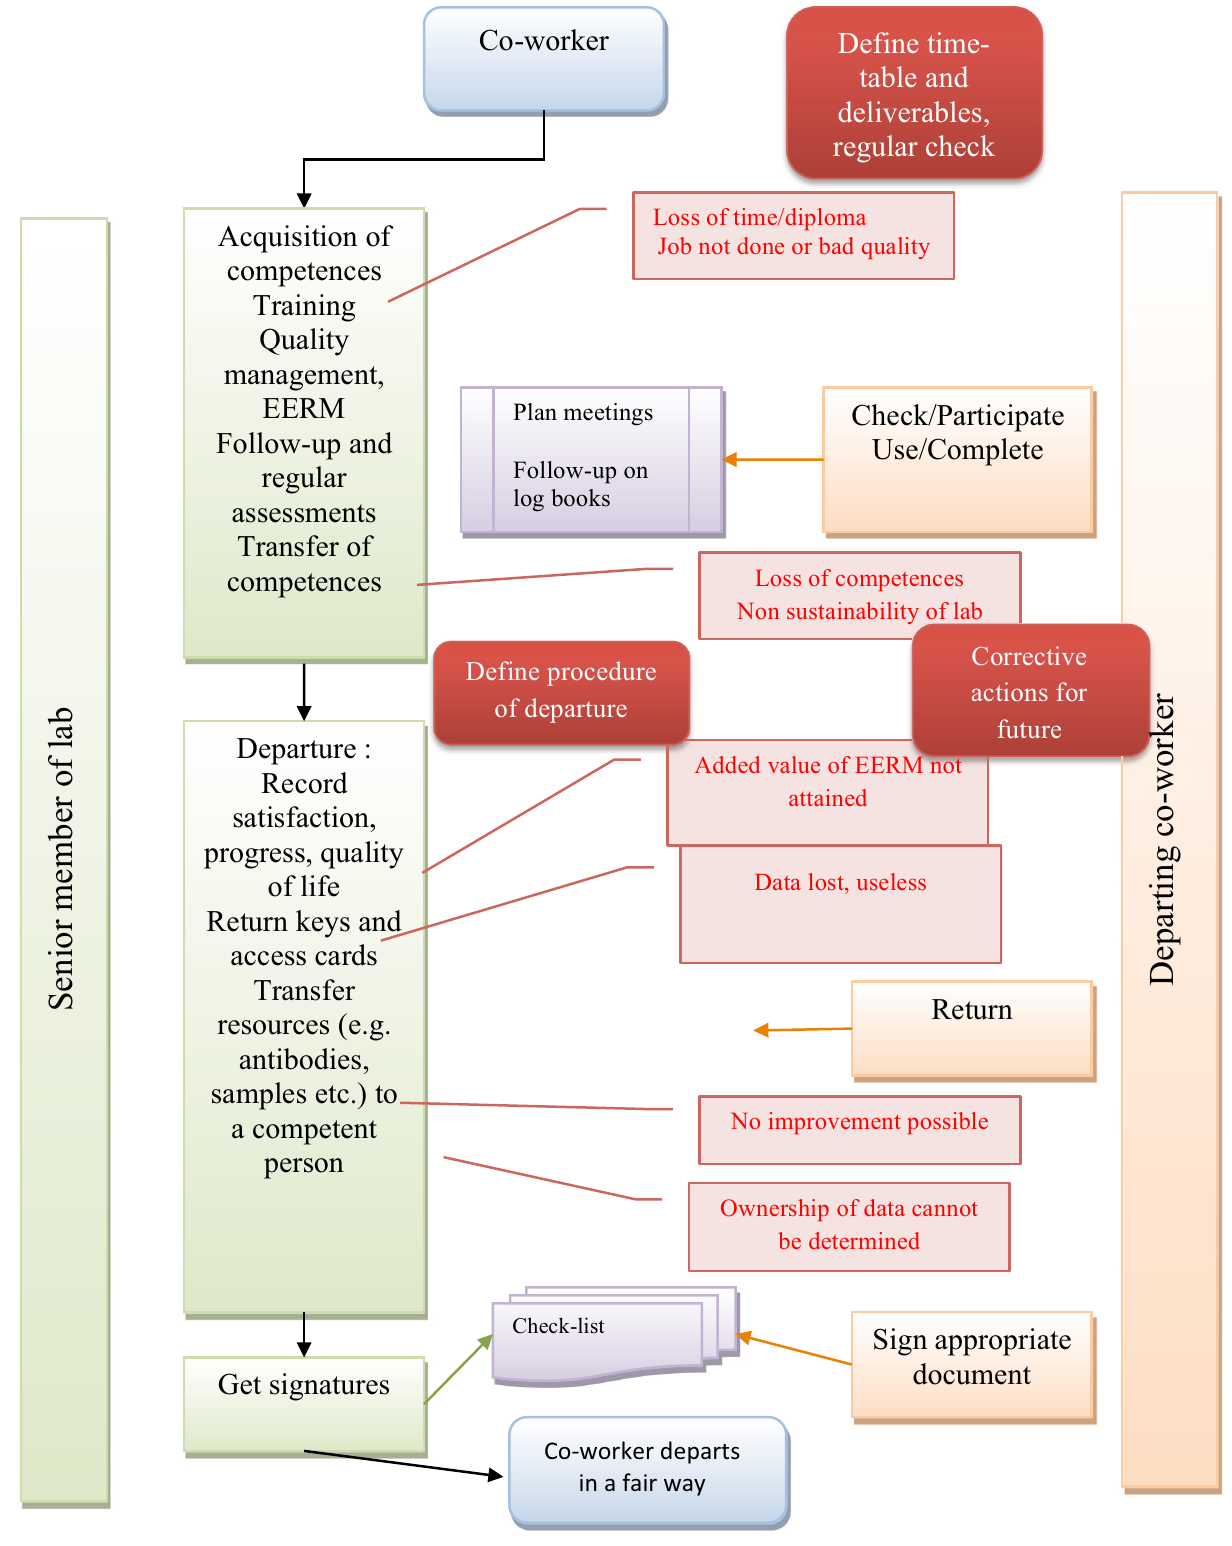
Fig. 7. Departure of a co-worker fl ow-chart with risky steps and management of the risk (dark